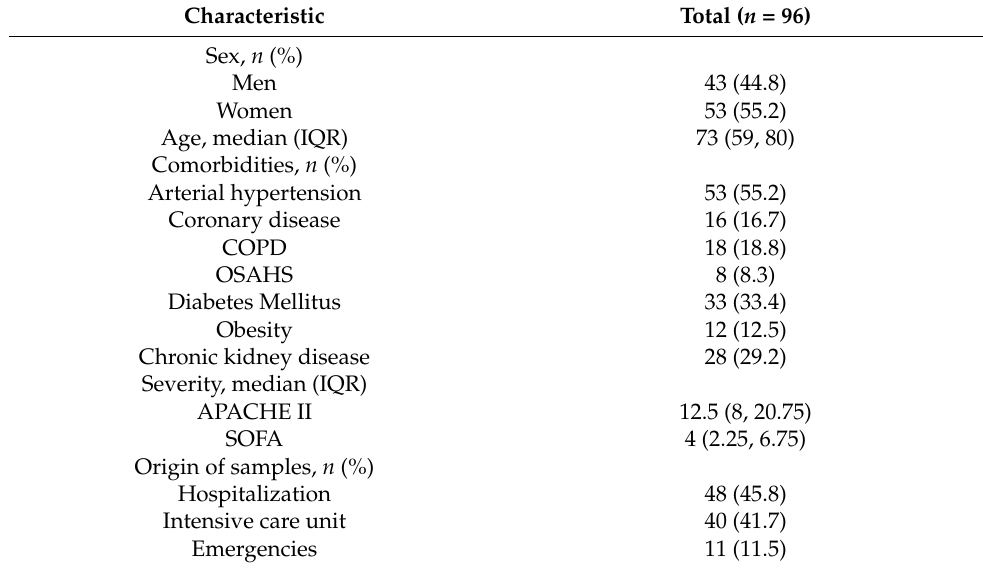
Table 1. General characteristics of patients with